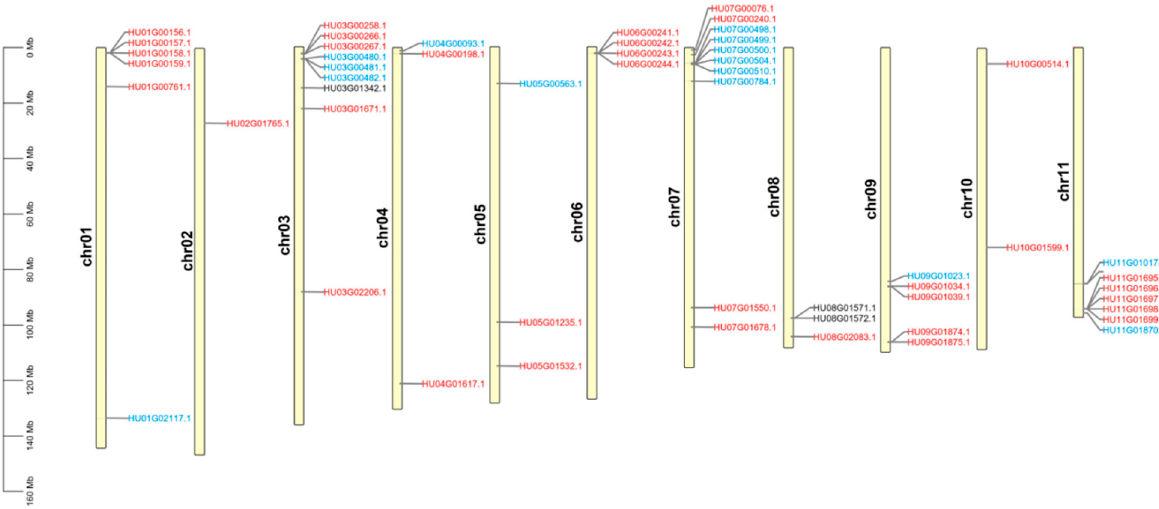
Figure 3. Chromosomal localization of CYP76AD , DODA and GTs genes in the H. undatus genome. CYP76AD (Blue): HU01G02117.1, HU03G00480.1, HU03G00481.1, HU03G00482.1, HU04G00093.1, HU05G00563.1, HU07G00498.1,